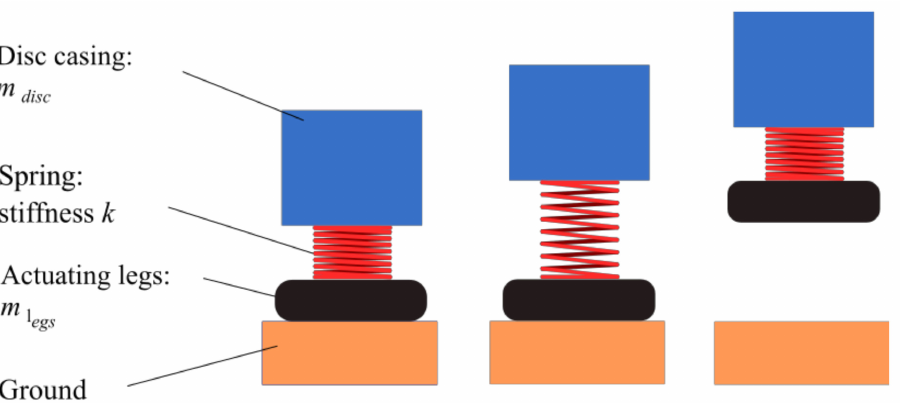
Figure 8. Schematics of the masses for the simplified analytical model. See Appendix A for more details.